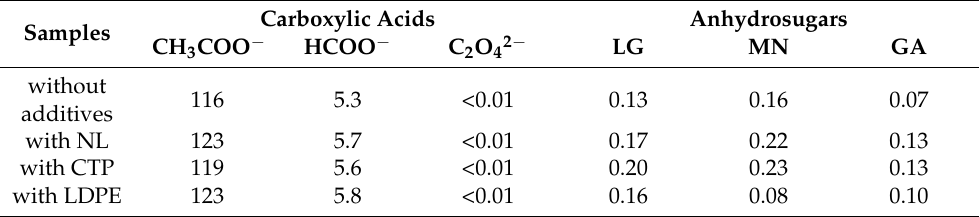
Table 4. The concentration of selected organic compounds present in the water condensates [mg/L].